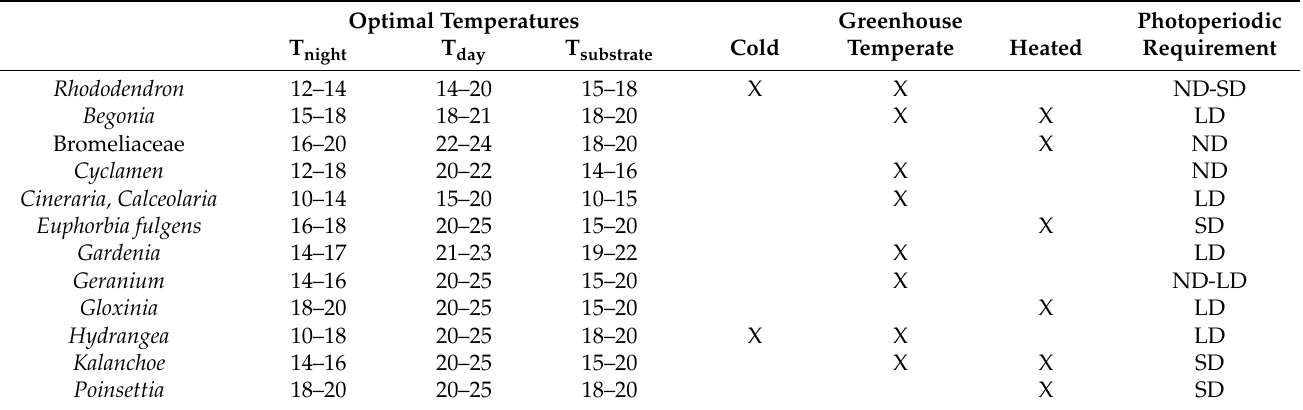
Table 2. Optimal temperatures, suitability for different air conditioning levels in greenhouses (based on minimum night temperature, T night ), and photoperiodic requirement for flowering in the main flowering potted ornamentals